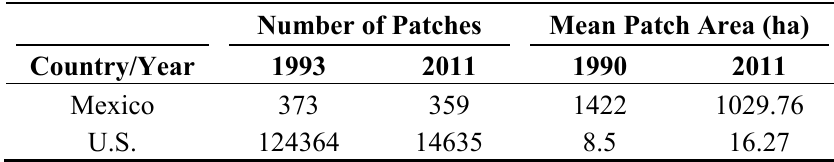
Table 5. General fragmentation metrics.